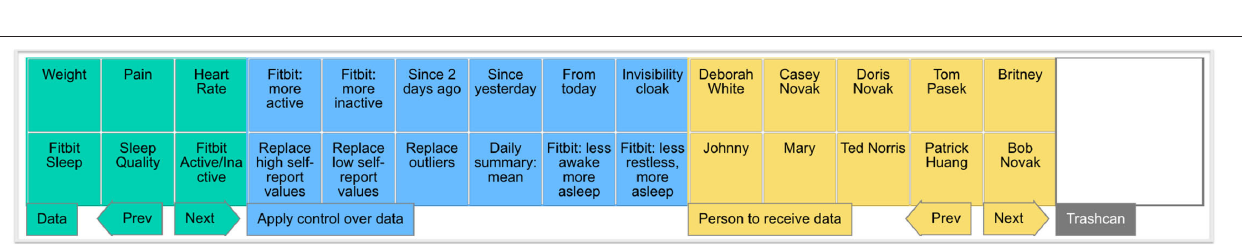
FIGURE 2 | DC: On the left is (a) a grid-based interface for specifying sharing settings, and on the right (c) is a panel that shows the preview of data being shared in a recipient’s view (Profile photos by Julian Wan and Leon Ell’ on Unsplash).